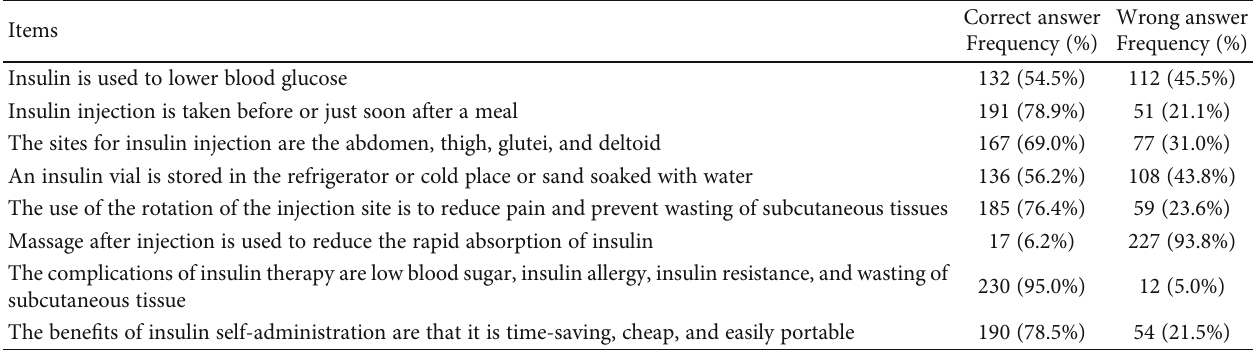
Table 2: Knowledge regarding ISA among type 1 diabetic patients at MKRH, 2019.